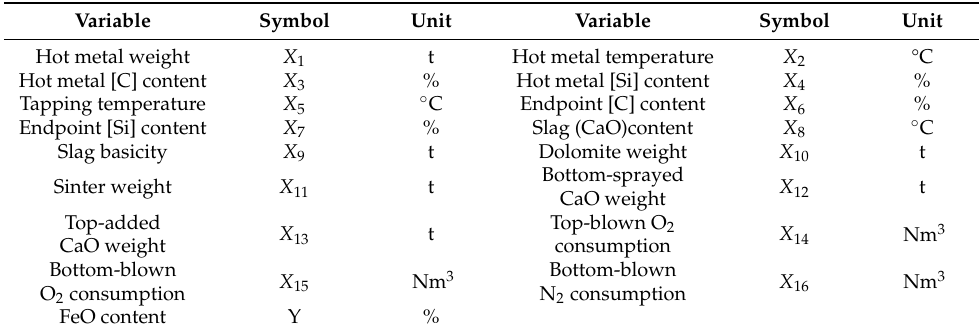
Table 2. Descriptive statistics of the process